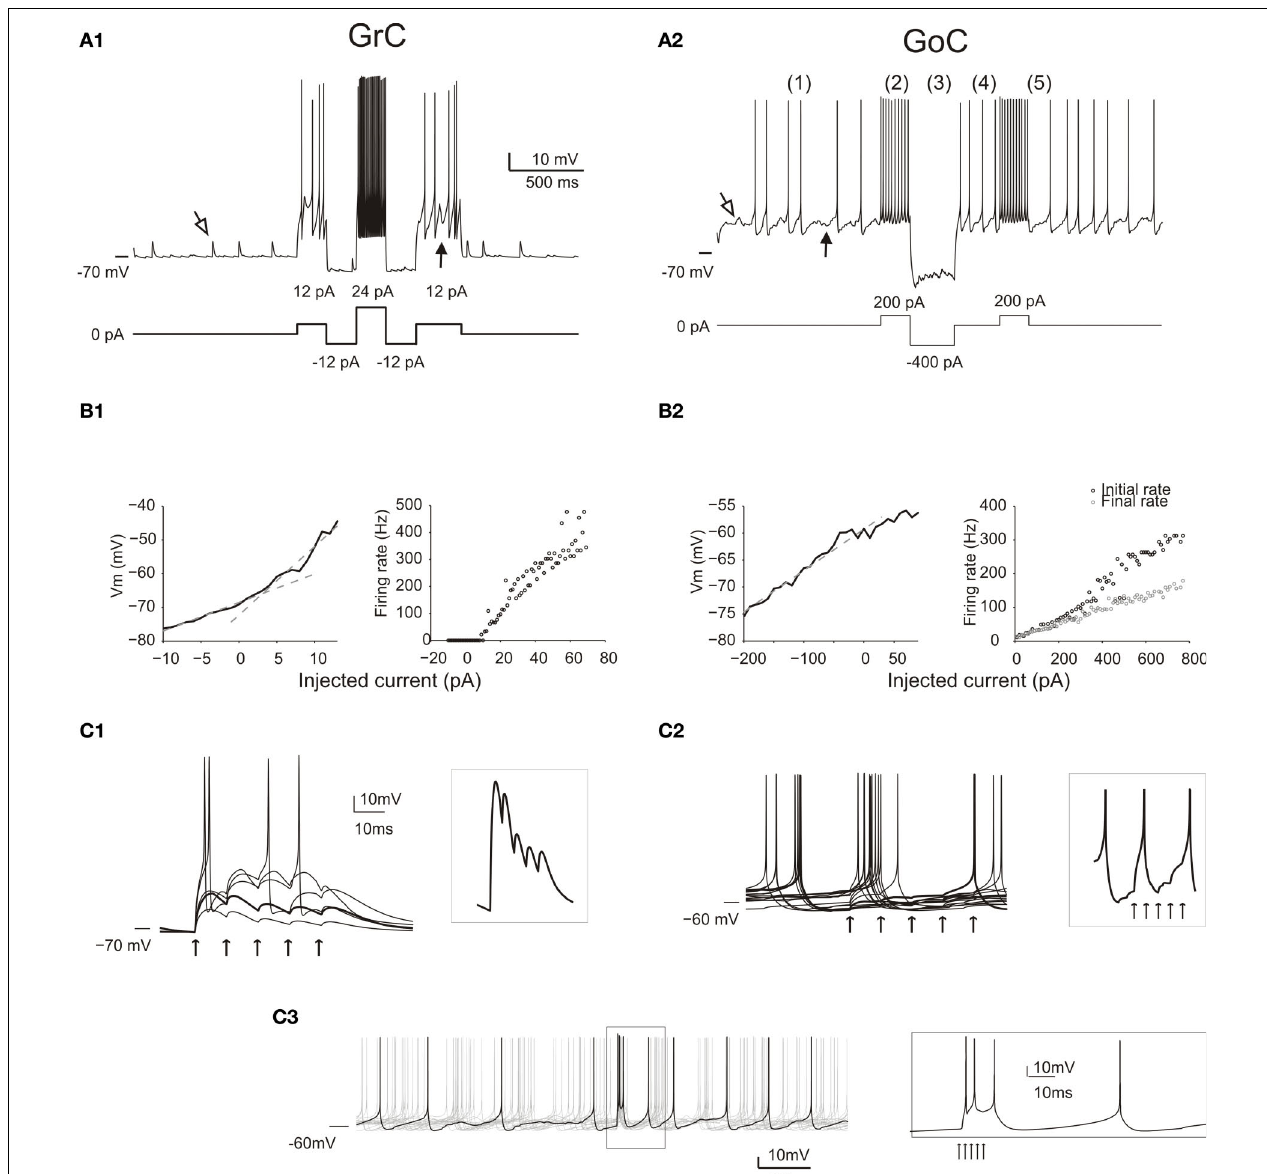
GrC shows an almost linear spike frequency increase up to 500 Hz. The GoC does not show fast inward rectifi cation (the V/I curve is fi tted with a single straight lines, with slope corresponding to input resistance 80 MOhm). The GrC shows an almost linear spike frequency increase up to 300 Hz and a rapid adaptation nearly halving the fi ring frequency. (C) The effect of an input spike burst (fi ve spikes at 100 Hz on eight contiguous mfs) on GrCs (C1) and GoCs (C2, C3) . Examples are taken from neurons receiving a variable number of mf inputs. The GrCs (C1) receive from one to fi ve active inputs. With weak activation EPSP short-term depression is visible (thick trace also enlarged in the inset), while with strong activation the GrCs emit short spike bursts. When the GoC receives eight active mf inputs (C2) , the different traces show a single spike occurring at different phases of the pacemaking cycle followed by phase reset. Individual EPSPs are small and barely visible (thick trace also enlarged in the inset). When the GoC receives 45 mf inputs (5 spikes at 500 Hz) (C3) , the traces show a short burst of two to three spikes at high frequency followed by phase-reset. The spikes in the burst (see inset) arise in 1.5 ms after the stimulus and then occur after 3.3, 7.6 and 47.2